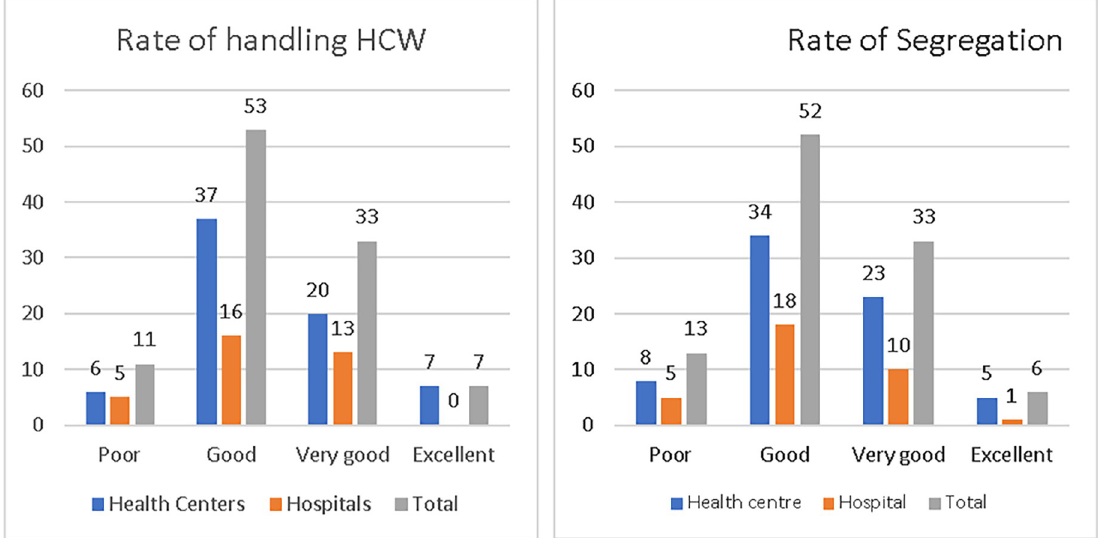
Fig 5. Rate of handling (a) and segregation (b) of HCW in the study health facilities, Addis Ababa City Administration, February 2018.